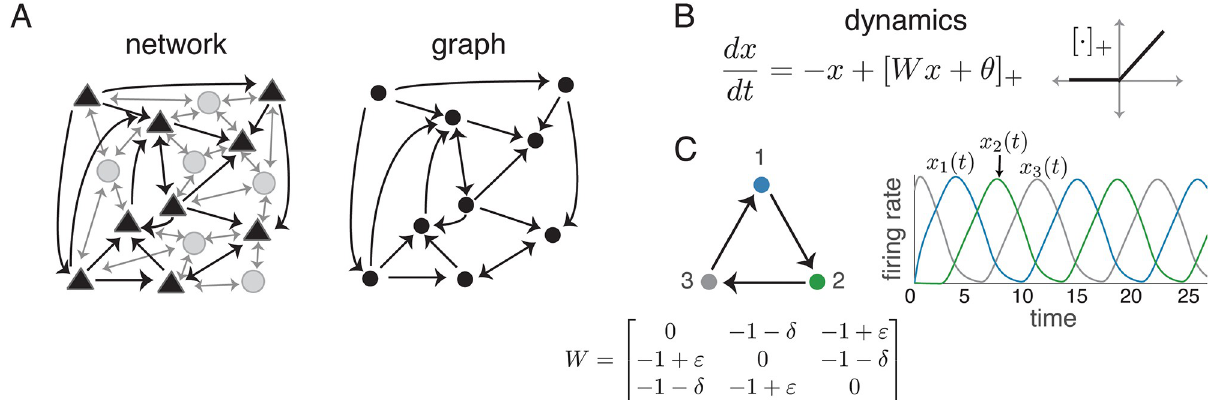
Fig 1. CTLNs. (A) A neural network with excitatory pyramidal neurons (triangles) and a background network of inhibitory interneurons (gray circles) that produces a global inhibition. The corresponding graph (right) retains only the excitatory neurons and their connections. (B) TLN dynamics and the graph of the threshold-nonlinearity [ � ] + = max{0, � }. (C) A graph that is a 3-cycle (left) and its corresponding CTLN matrix W . (Right) A solution for the corresponding CTLN, with parameters ε = 0.25, δ = 0.5, and θ = 1, showing that network activity follows the arrows in the graph. Peak activity occurs sequentially in the cyclic order